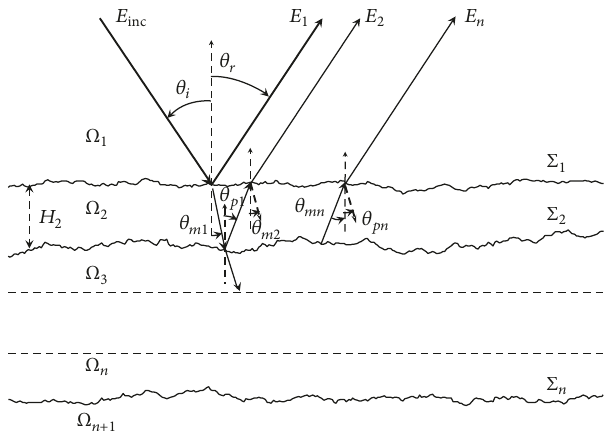
Figure 2: Configuration of the different orders of reflection from a multilayer, focus on the upper layer Ω 2